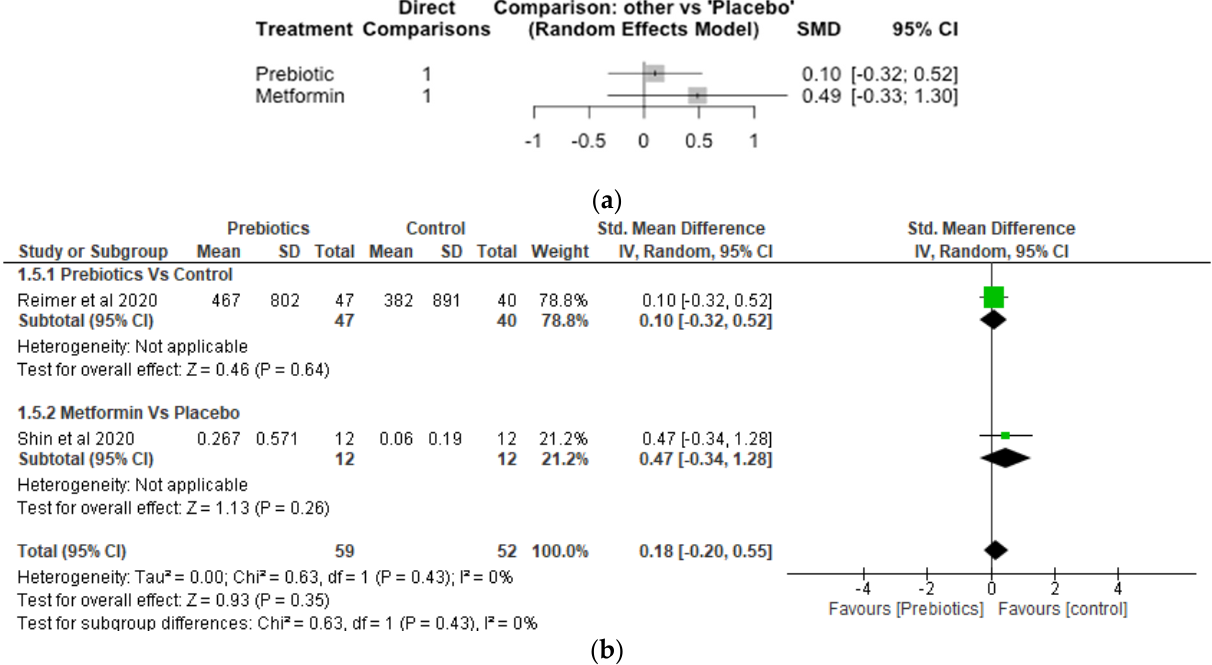
Figure 5. Network Meta-analysis ( a ) and Meta-analysis ( b ) of the effect of treatments versus control on Akkermansia [41,42].